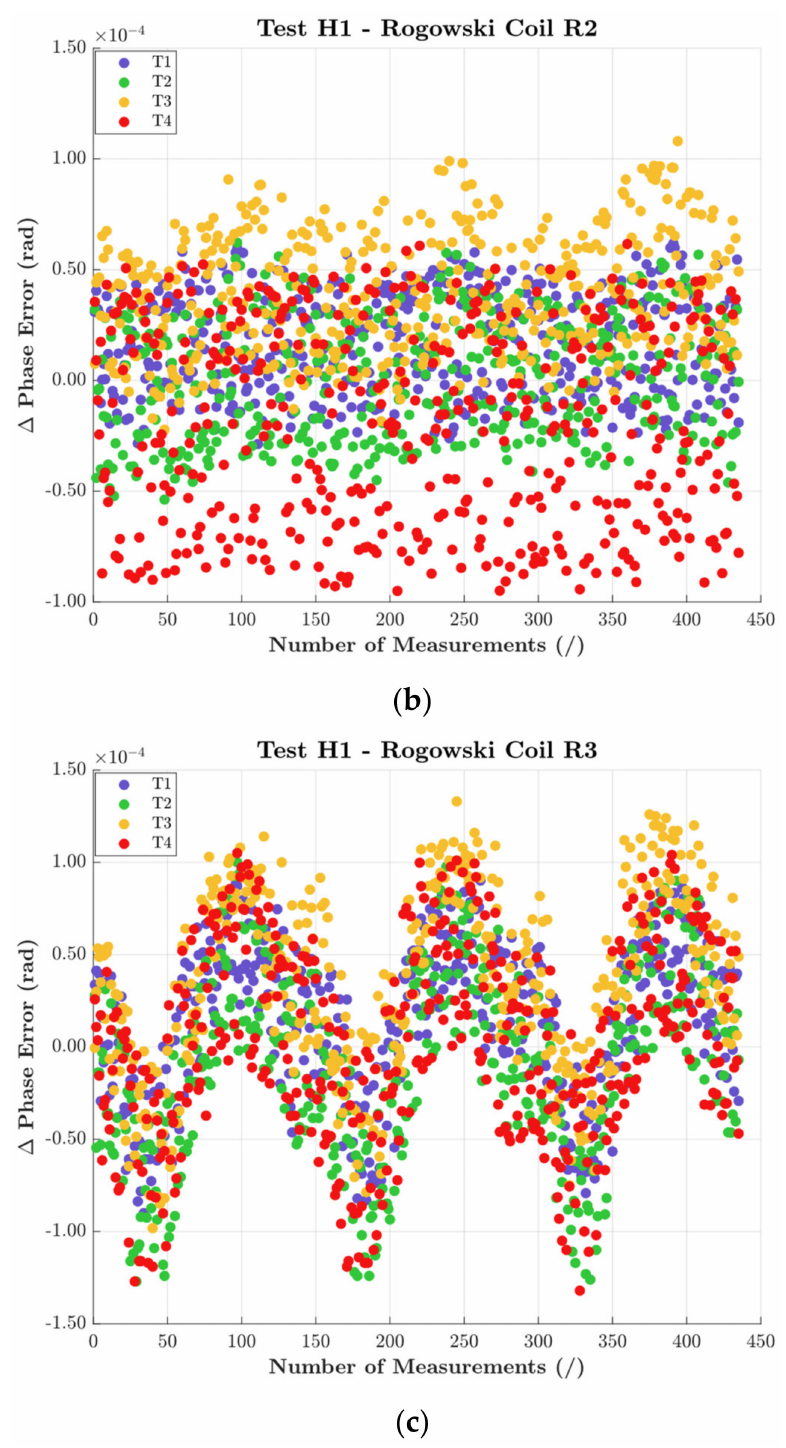
Figure 6. ∆ ϕ results of the test performed with H1 and all positions for ( a ) R1, ( b ) R2, and ( c ) R3. The same tests were performed, as previously described, with signal H2. The results, omitted here for the sake of brevity, presented coherent behaviors without any significant variation due to a different THD. However, more interesting comments on the harmonic evaluation are included in the following